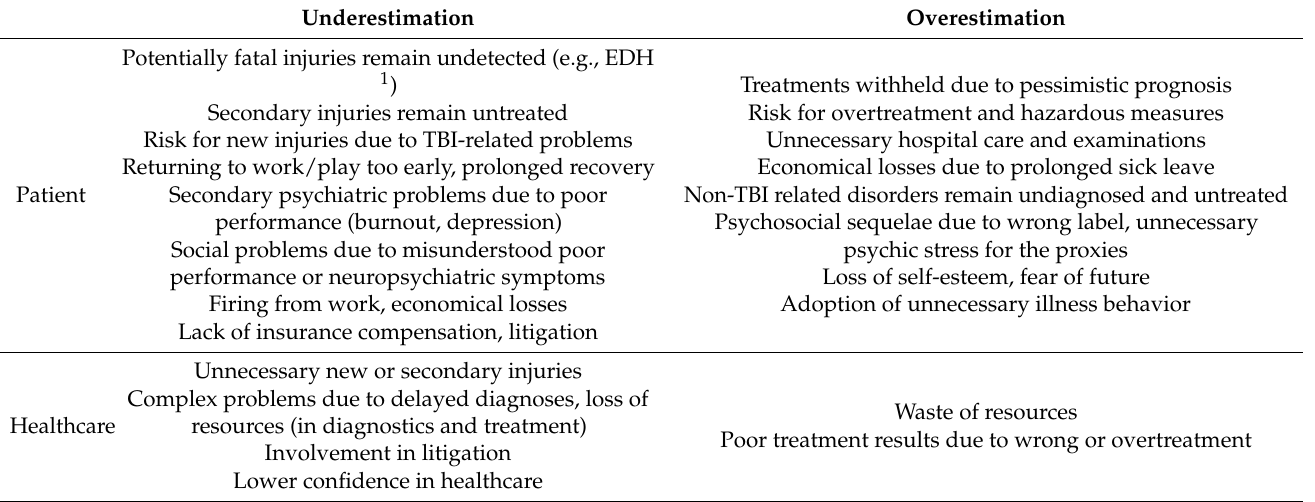
Table 3. Potential negative consequences of wrong estimates of TBI